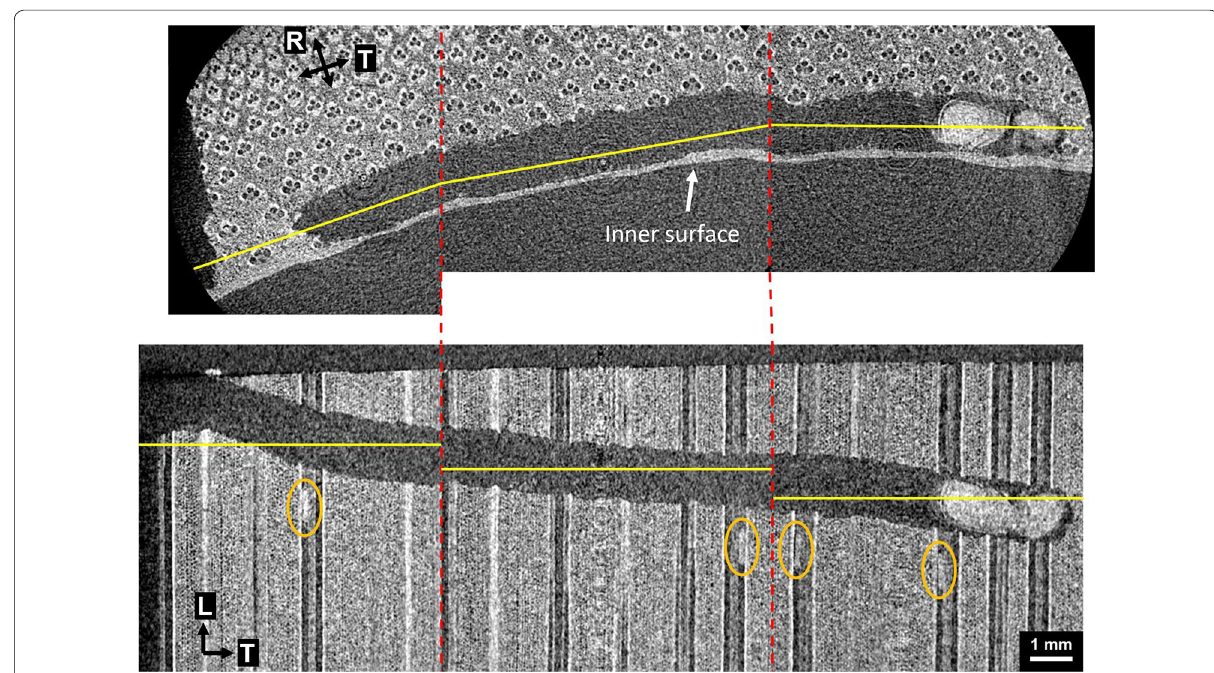
Fig. 4 Combined CT images capturing the oviposition tunnel of individual F1 and eggs ( yellow circles ) deposited in the metaxylem vessels, obtained using high magnification scans. Yellow lines indicate the positions of the corresponding planes